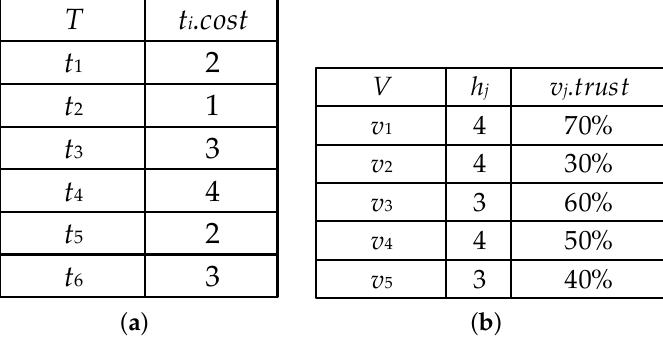
Figure 3. Task set and volunteer node set at time l 1 . ( a ) task set at time l 1 ; ( b ) volunteer node set at time l 1 .